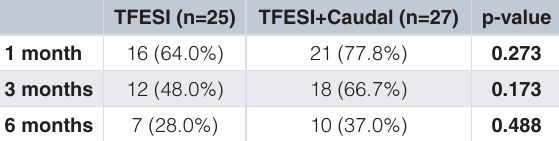
Table 4. The number of patients with improvement of Oswestry Disability Index at 15-points or greater at each follow-up period in chronic lumbosacral radicular pain.